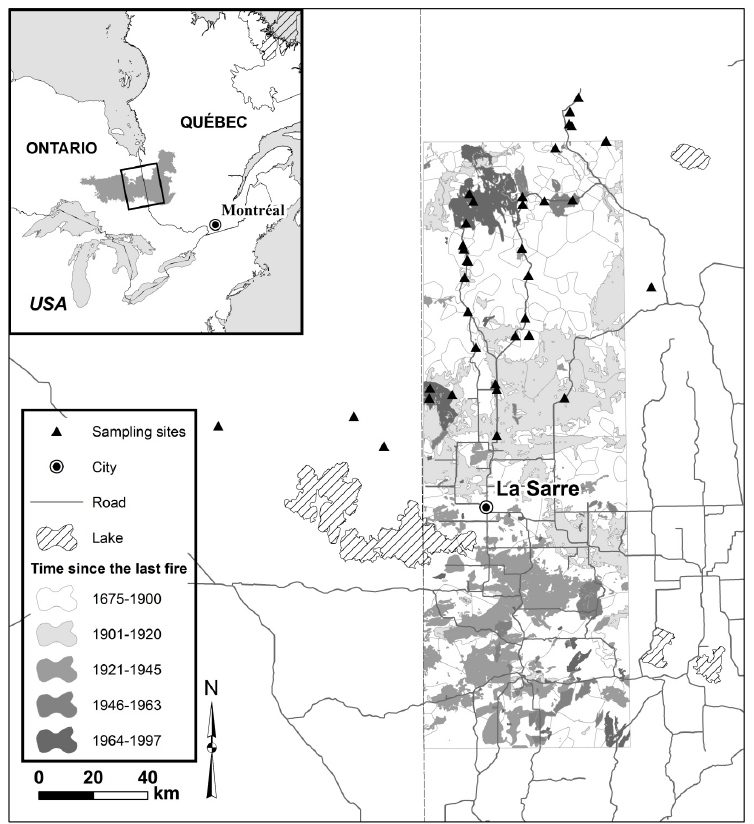
Figure 1. Geographic location of the sampling sites in the Clay Belt boreal forest, eastern North America.